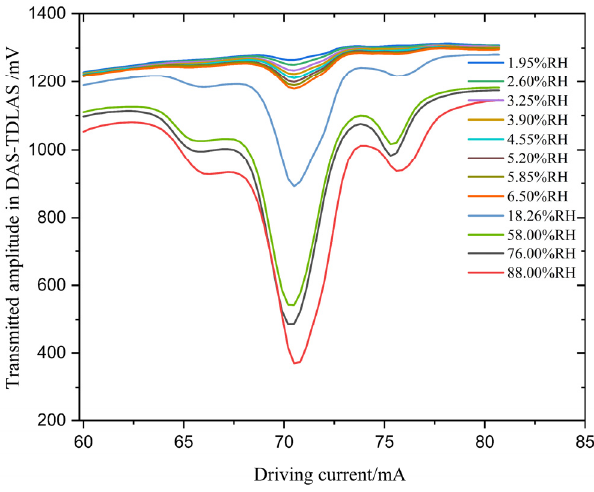
Figure 6. Transmitted amplitude in the DAS-TDLAS mode.